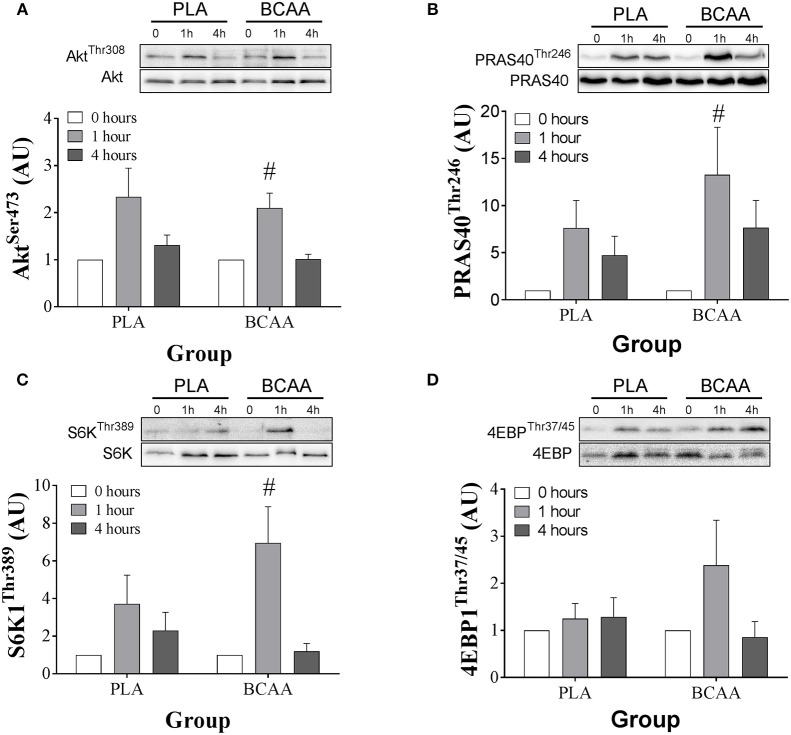
Phosphorylation status of, AKTSer473
(A), PRAS40Thr246
(B), S6K1Thr389
(C), and 4EBP1Thr37/45
(D) immediately pre (0 h), 1-, and 4 h-post ingestion of either a branched-chain amino acid containing drink (BCAA, black bars) or placebo drink (PLA, white bars) following resistance exercise. Data are displayed as means ± SE. #Significant difference from 0 h in respective trials (P < 0.05).